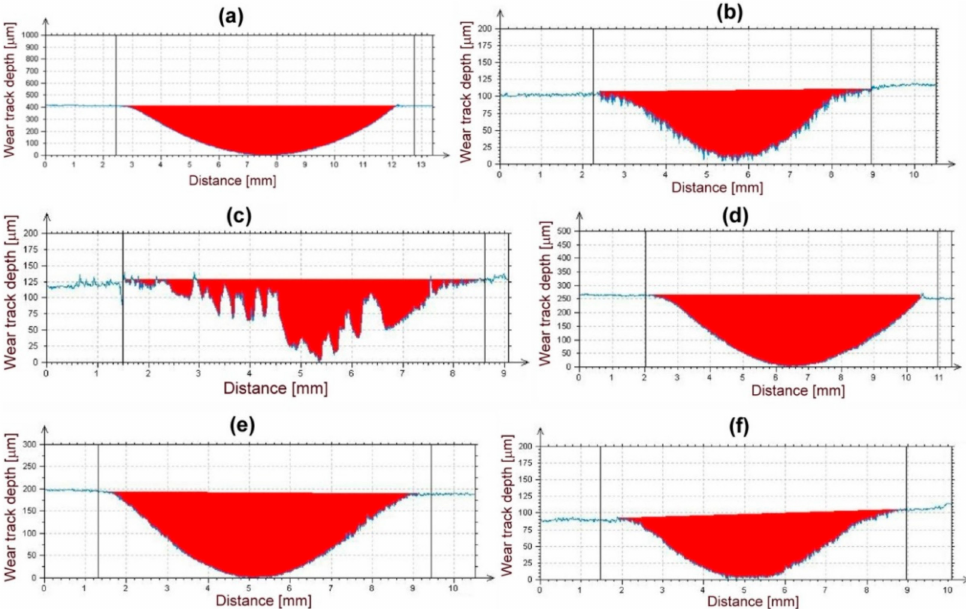
Figure 10. Typical cross-sectional profiles of wear tracks generated on the surfaces of investigated materials after abrasion wear tests: 16MnCr5 grade steel ( a ); “E520 RB” hardfacing ( b ); “RD 571” hardfacing ( c ); “LNM 420FM” hardfacing ( d ); “E DUR 600” hardfacing ( e ); “Weartrode 62” hardfacing ( f